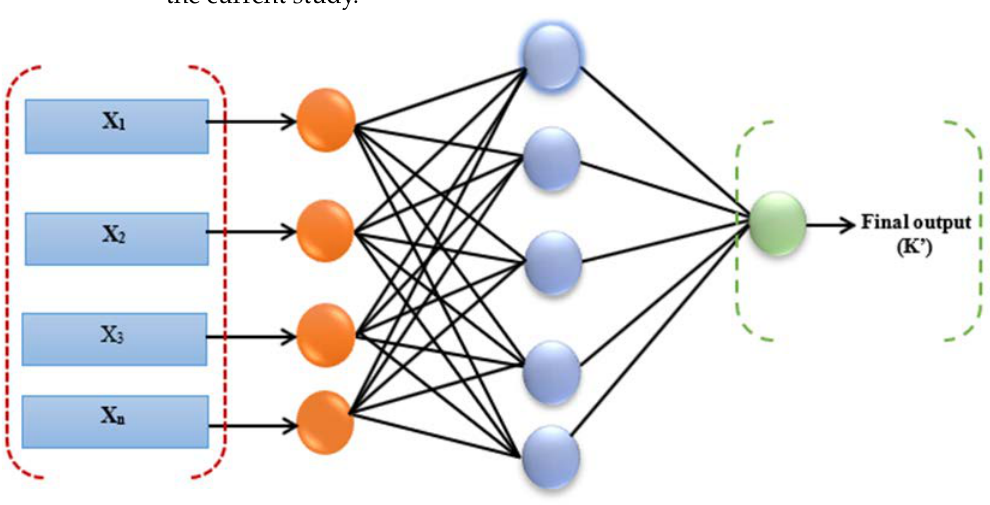
Figure 1. The three-layer feed-forward neural network architecture used in the current study.